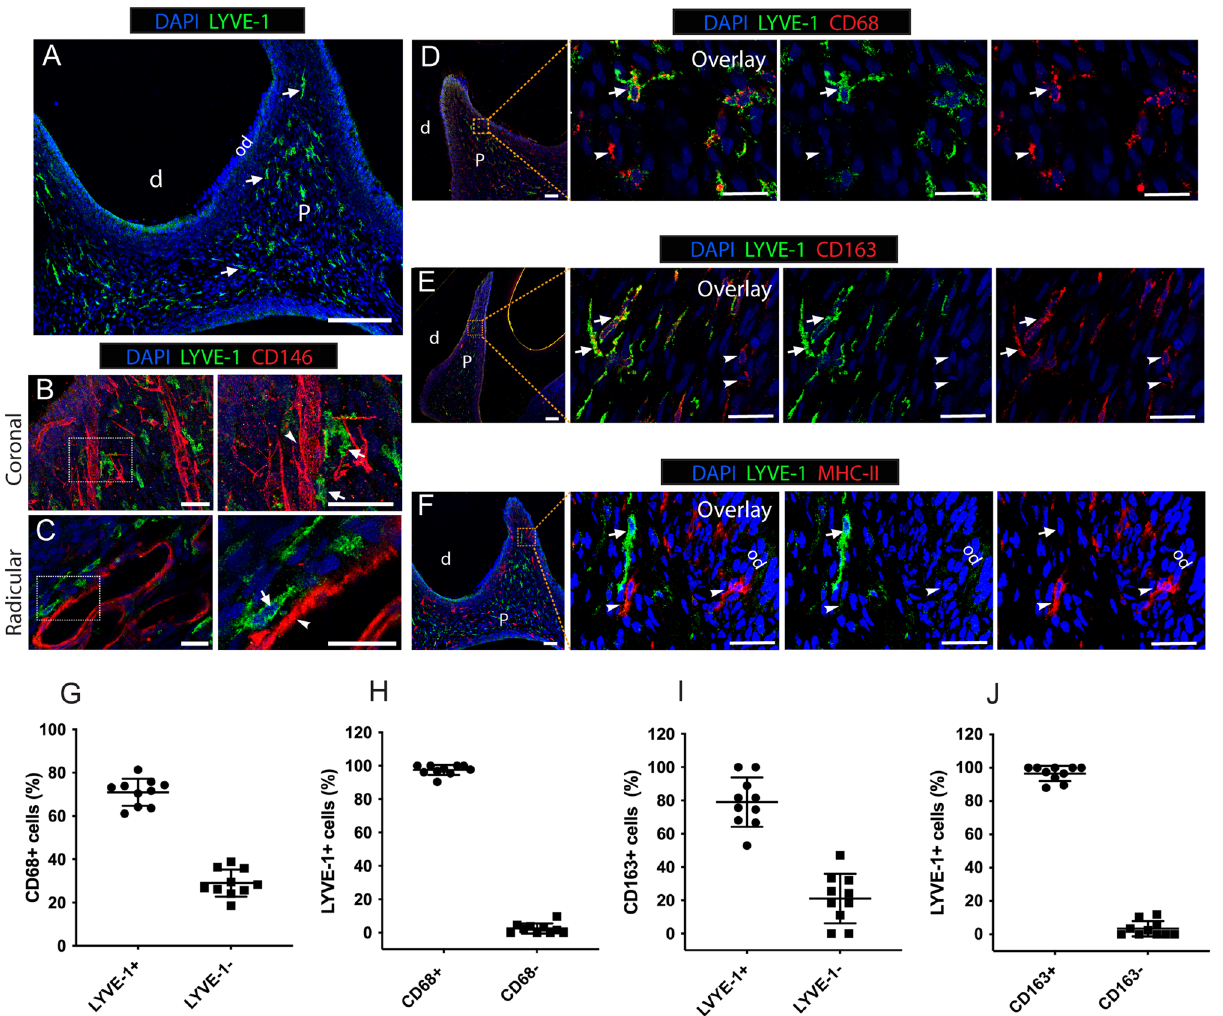
Figure 1. The phenotype of resident LYVE-1 + macrophages in dental pulp tissue of rats (8 weeks old). ( A ) Immunofluorescence staining of LYVE-1 in rat molar sections. Arrows: LYVE-1 + macrophages. ( B , C ). Double immunofluorescence staining of LYVE-1 (green) and endothelial cells marker CD146 (red) in rat molar sections. Arrows: LYVE-1 + macrophages; arrowheads: blood vessels. ( D ) Double immunofluorescence staining of LYVE-1 (green) and pan-macrophage marker CD68 (red) in rat molar sections. Arrows: LYVE- 1 + CD68 + macrophages; arrowheads: LYVE-1 - CD68 + macrophages. ( E ) Double immunofluorescence staining of LYVE-1 (green) and M2 macrophage marker CD163 (red) in rat molar sections. Arrows: LYVE-1 + CD163 + ; arrowheads: LYVE-1 − CD163 + macrophages. ( F ) Double immunofluorescence stained of LYVE-1 (green) and antigen-presenting cell marker MHC-II (red) in rat molar sections. Arrows: LYVE-1 + MHC-II − macrophages; arrowheads: LYVE-1 - MHC-II + macrophages. ( G – J ). Percentages of macrophage subsets by cell counting (mean ± SD; n = 10). Images are representative of at least 3–4 different samples for each examined condition. d dentin, od odontoblast layer, p dental pulp. Scale bar 200 µm ( A ) and 50 µm ( B – F